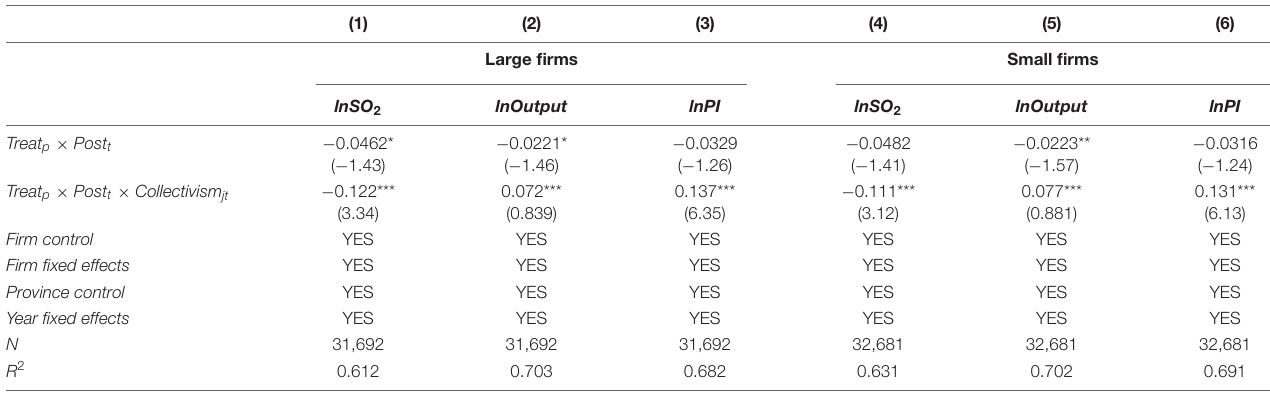
TABLE 5 | Heterogeneity of policy effects between large and small firms.